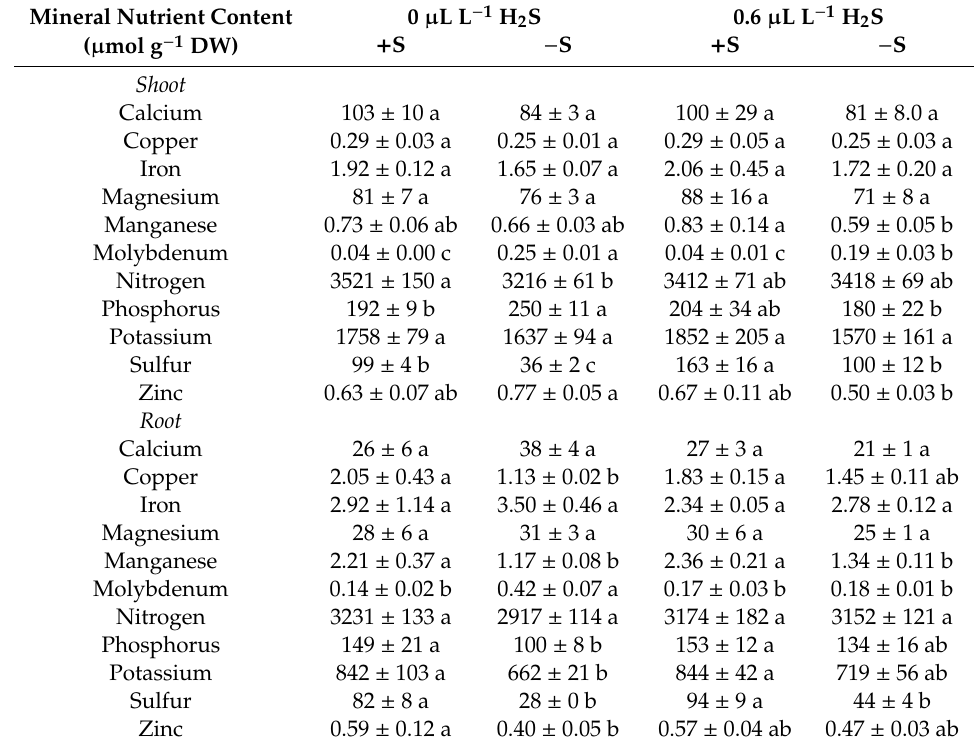
Table 1. Mineral nutrient content of barley shoots and roots in the presence and absence of a H 2 S and sulfate supply. For experimental details, see the legend of Figure 1. Data represent the average of 3 measurements with 6 plants per measurement ( ± SD). Significant di ff erences between treatments are indicated with di ff erent letters ( P ≤ 0.05; two-way ANOVA; Tukey’s HSD test as a post-hoc